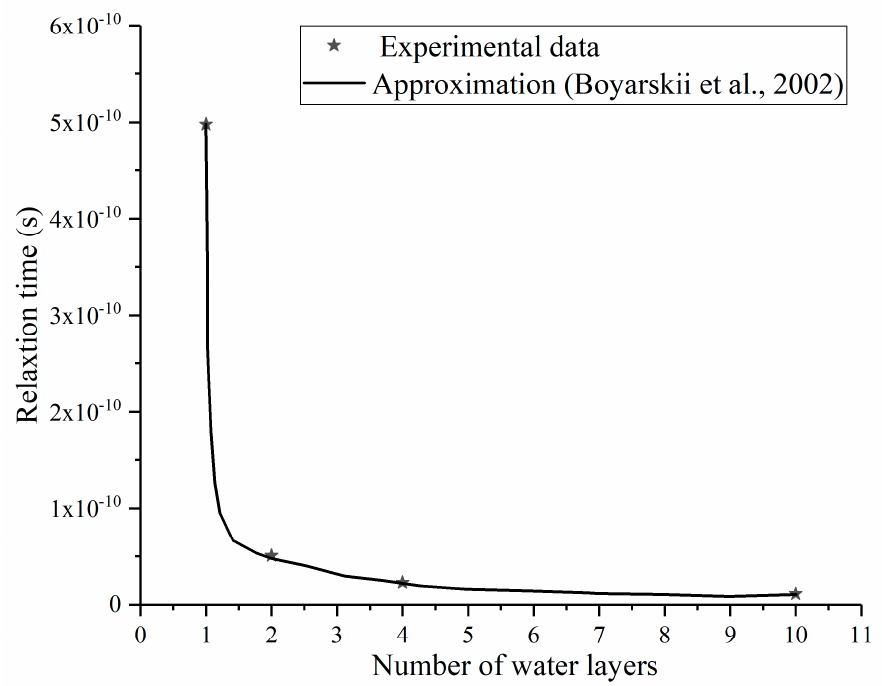
Figure 2. Fitting of the relationship between the relaxation time of bound water and the number of bound water layers on the soil particle surface. The fitting curve and measurements of this figure come from [12].